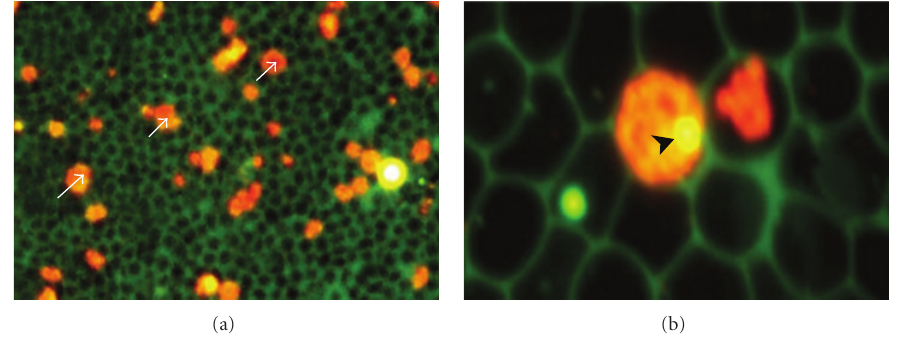
Figure 2: Micronucleus assay with mouse peripheral blood reticulocytes using acridine orange-coated slides. (a) Reticulocytes (white arrows) and erythrocytes (dark cells) (400x). (b) Micronuclei (head arrow) in reticulocyte (1000x).